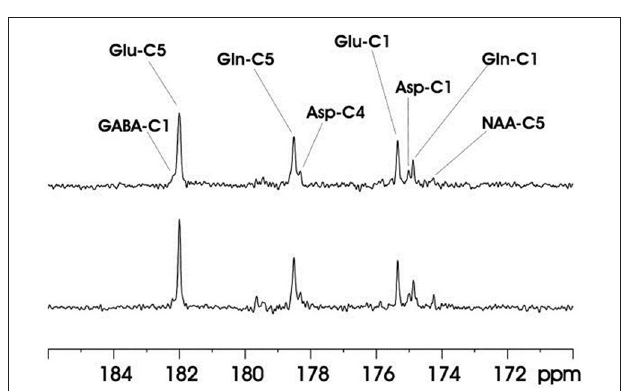
FIGURE 11 | In vivo 13 C MRS spectra acquired from the rat brain at 11.7 Tesla using Ernst’s stochastic decoupling sequence (top trace) and using the windowed stochastic decoupling sequence (bottom trace) at very low decoupling power. The decoupling of the original Ernst’s stochastic decoupling sequence in this study was 12.8% of that in Figure 10 . Acquisition parameters were identical to Figure 10 . Adapted from Xiang et al.